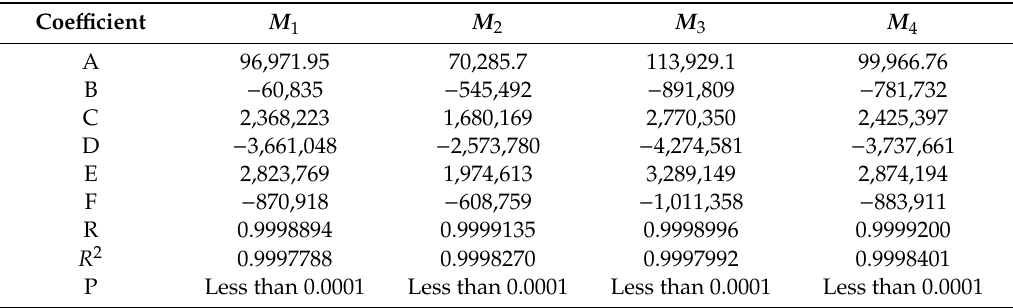
Table 2. Coe ffi cient of each motors for Equation